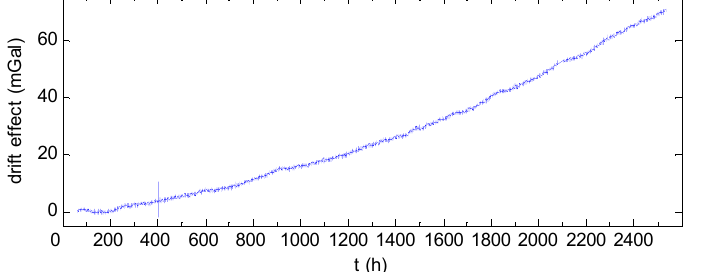
Figure 7. Gravimetric data after filtered and subtracted by starting value.